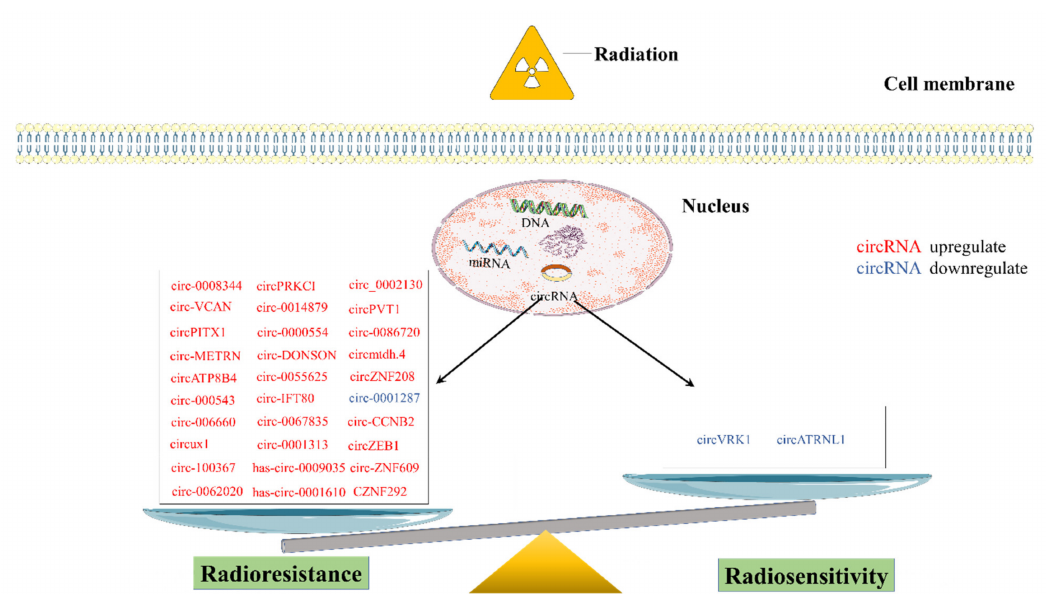
Figure 4. Role and regulatory pathways of cancer-related